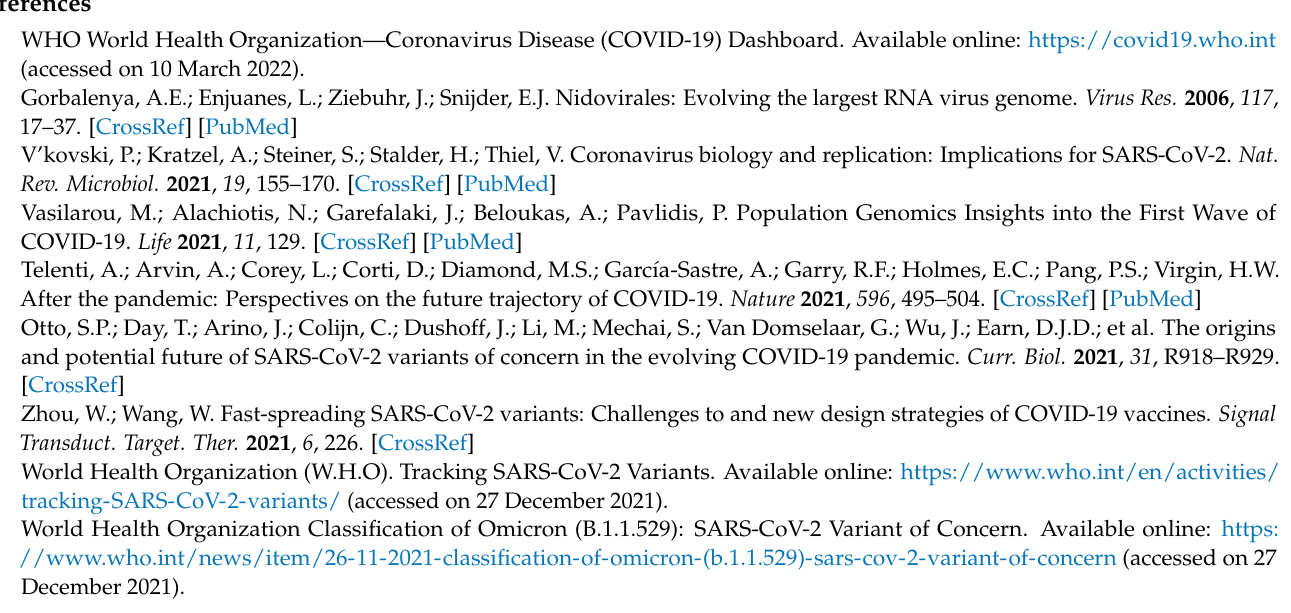
Table S3: Metadata, sequencing statistics, and lineage classification for all samples characterized through genome sequencing. Table S4: Lineage effect on Ct value at the national level and for each capital using a linear regression